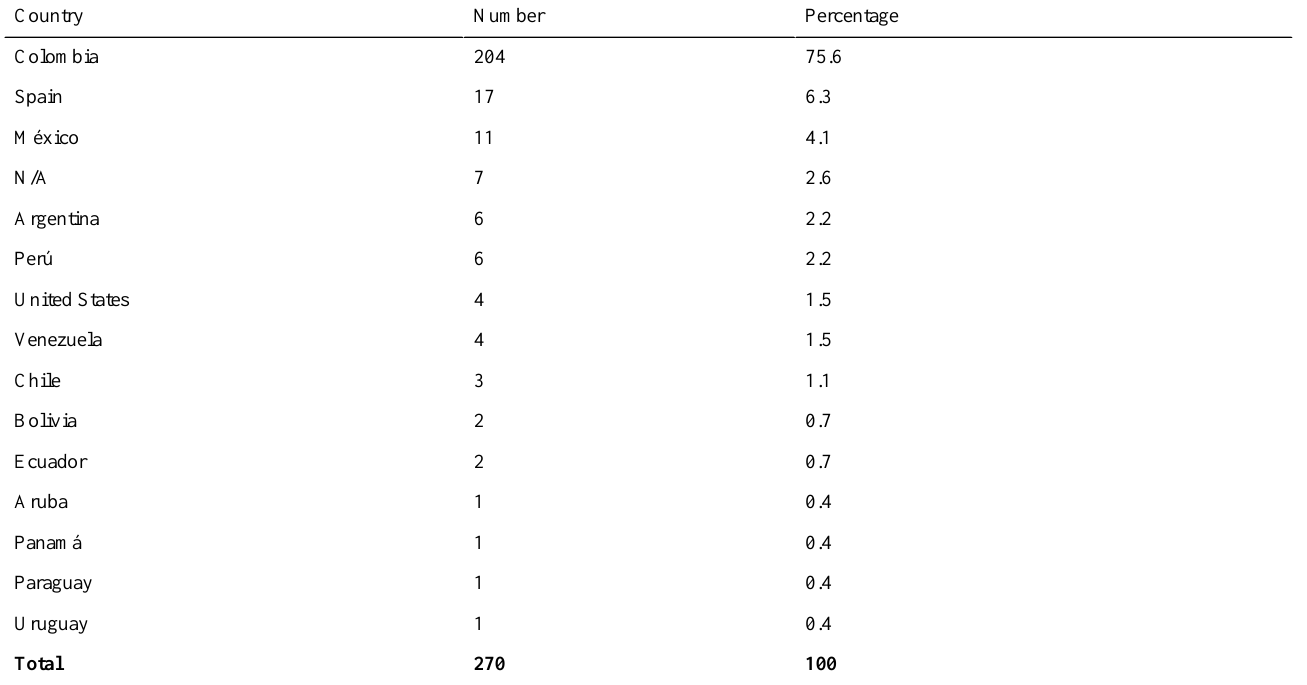
Table 4. Requests by